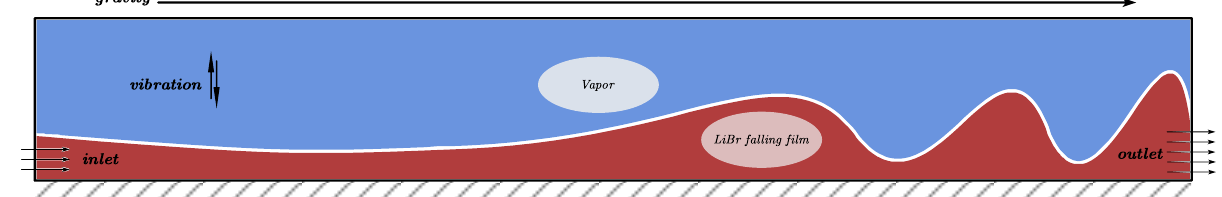
Figure 2. Falling-film flow diagram.